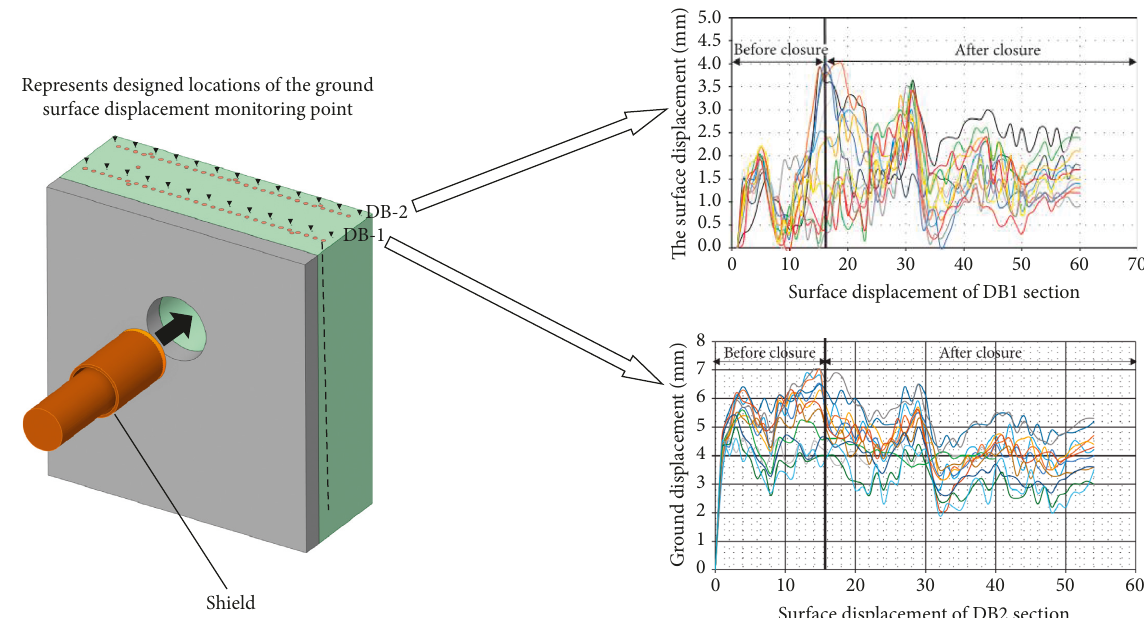
Figure 14: Cumulative settlement and surface displacement curve of No. 2 connecting channel in Minqing section.